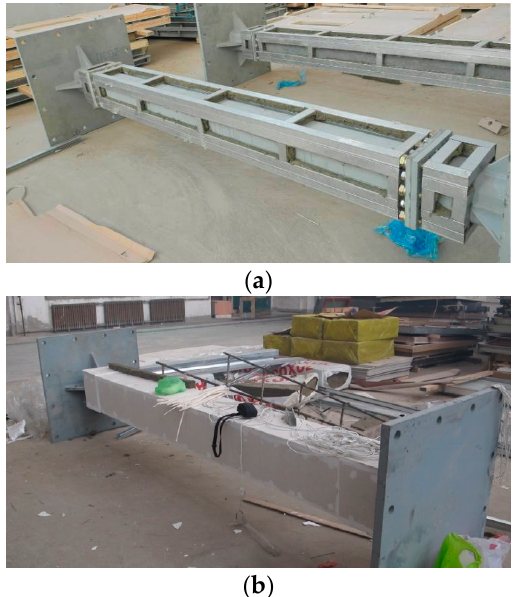
Figure 2. Fabrication of the column protection: ( a ) unprotected; ( b ) protected.